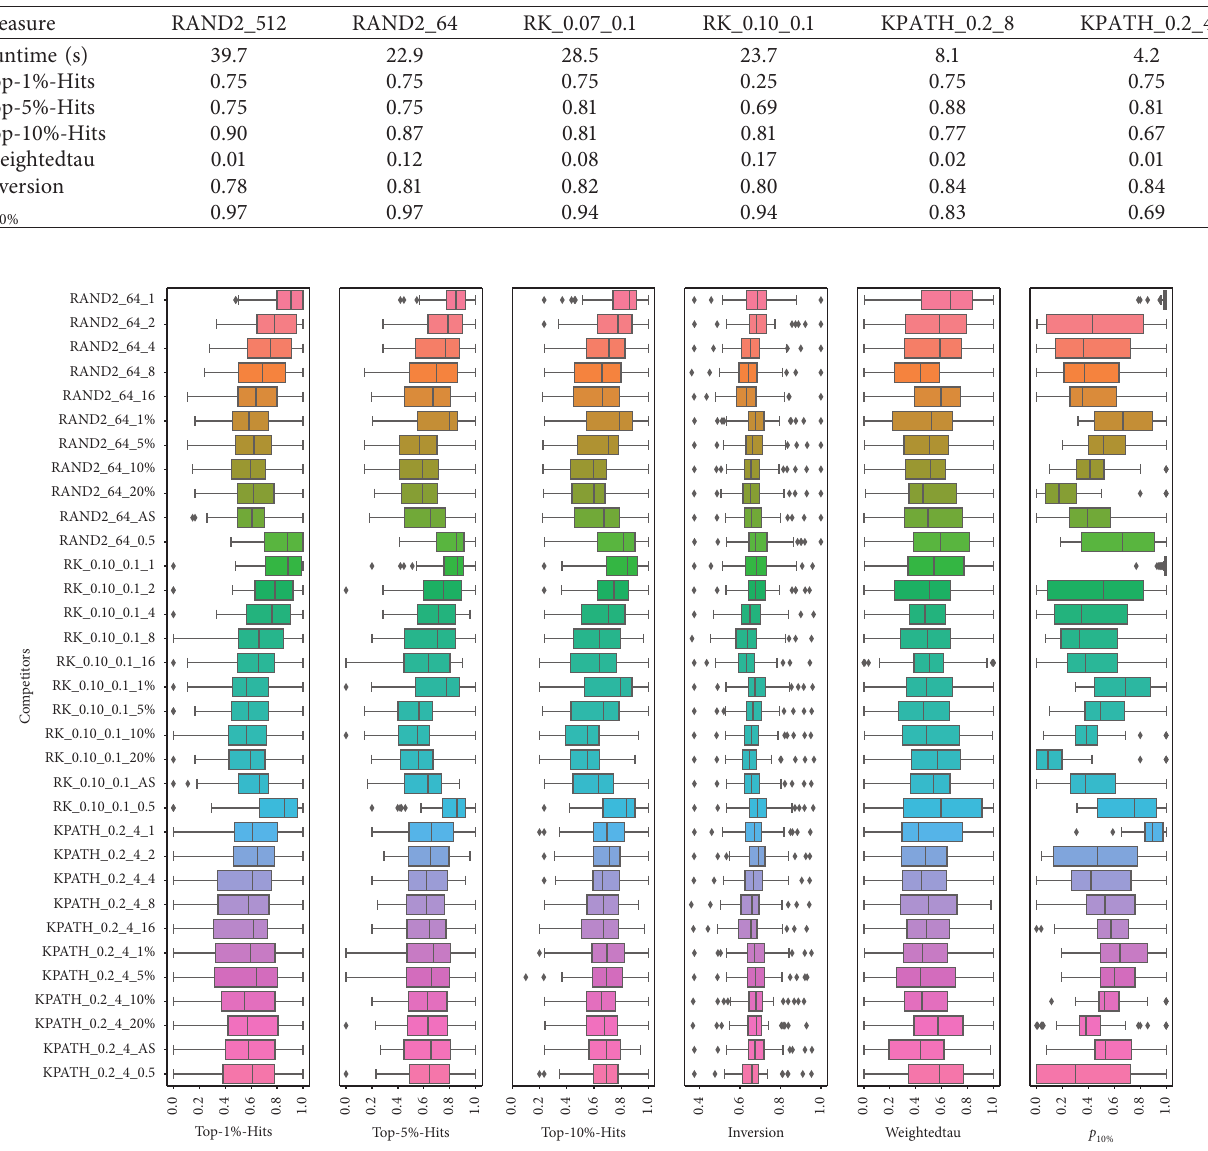
Figure 8: Distribution of measure values on 48 real-world